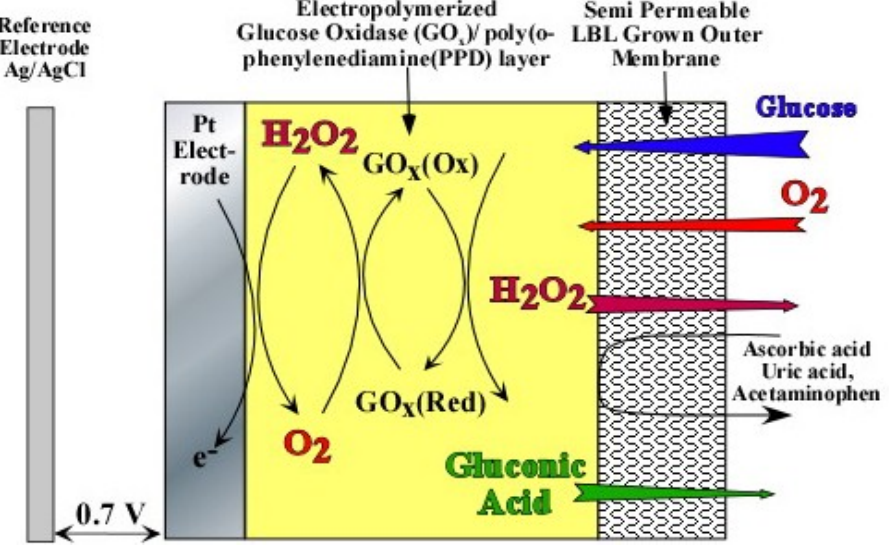
Figure 1. Cross-sectional schematic representation of the multi-layer amperometric glucose sensor used in the numerical simulations. The outer LBL membrane is represented as either one of the following systems: (i) HAs/Fe 3+ (ii)